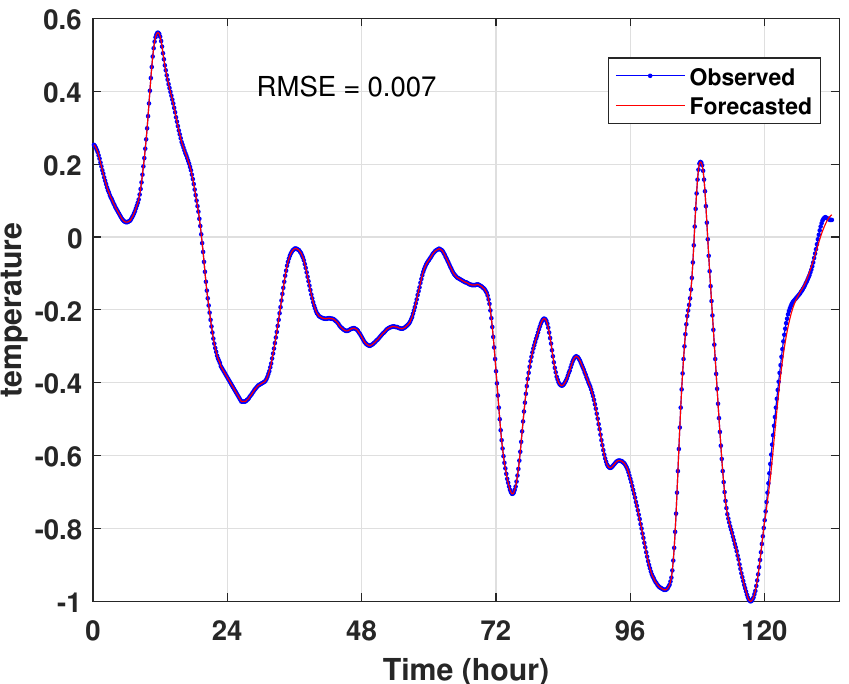
Figure 17. Temperature forecasting by PSO-LSTM.